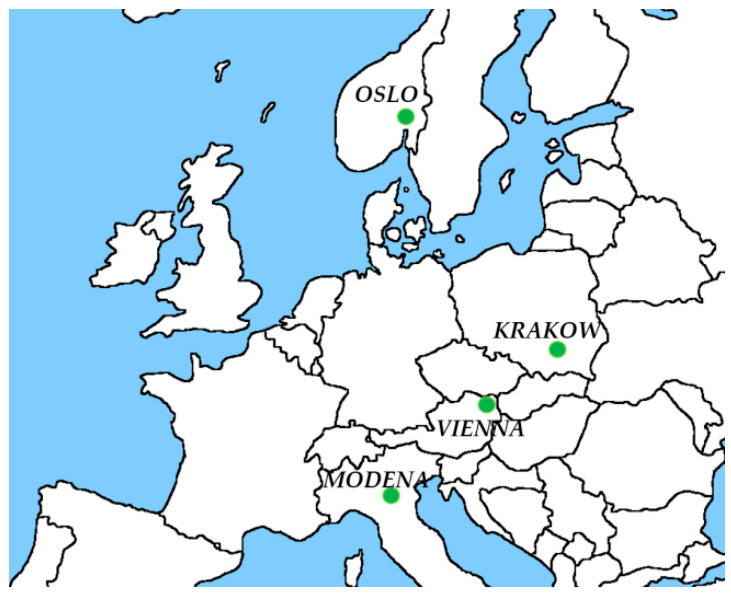
Figure 3. Building locations considered in the computational analysis.